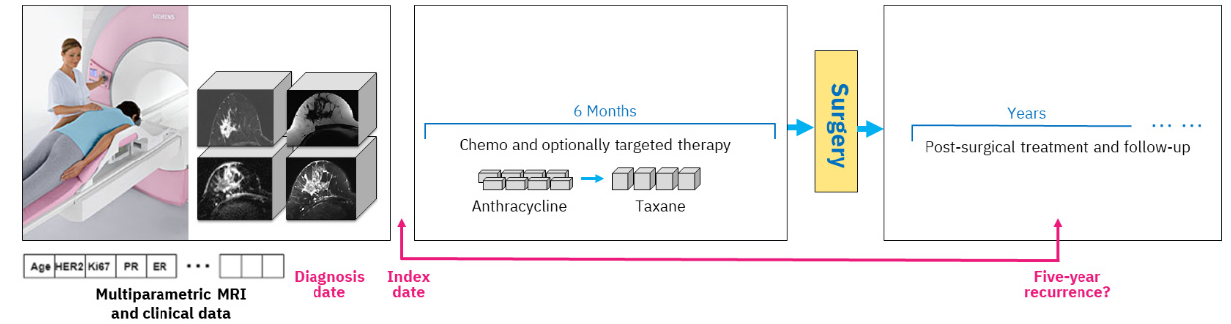
Figure 1. Study setting. Multiparametric MRI and clinical data acquired prior to NAC treatment start are analyzed to predict breast cancer recurrence within five years after diagnosis. The NAC treatment includes six months of chemotherapy with optional targeted treatment followed by surgery. After surgery, there is follow-up and sometimes additional treatment such as radiotherapy.